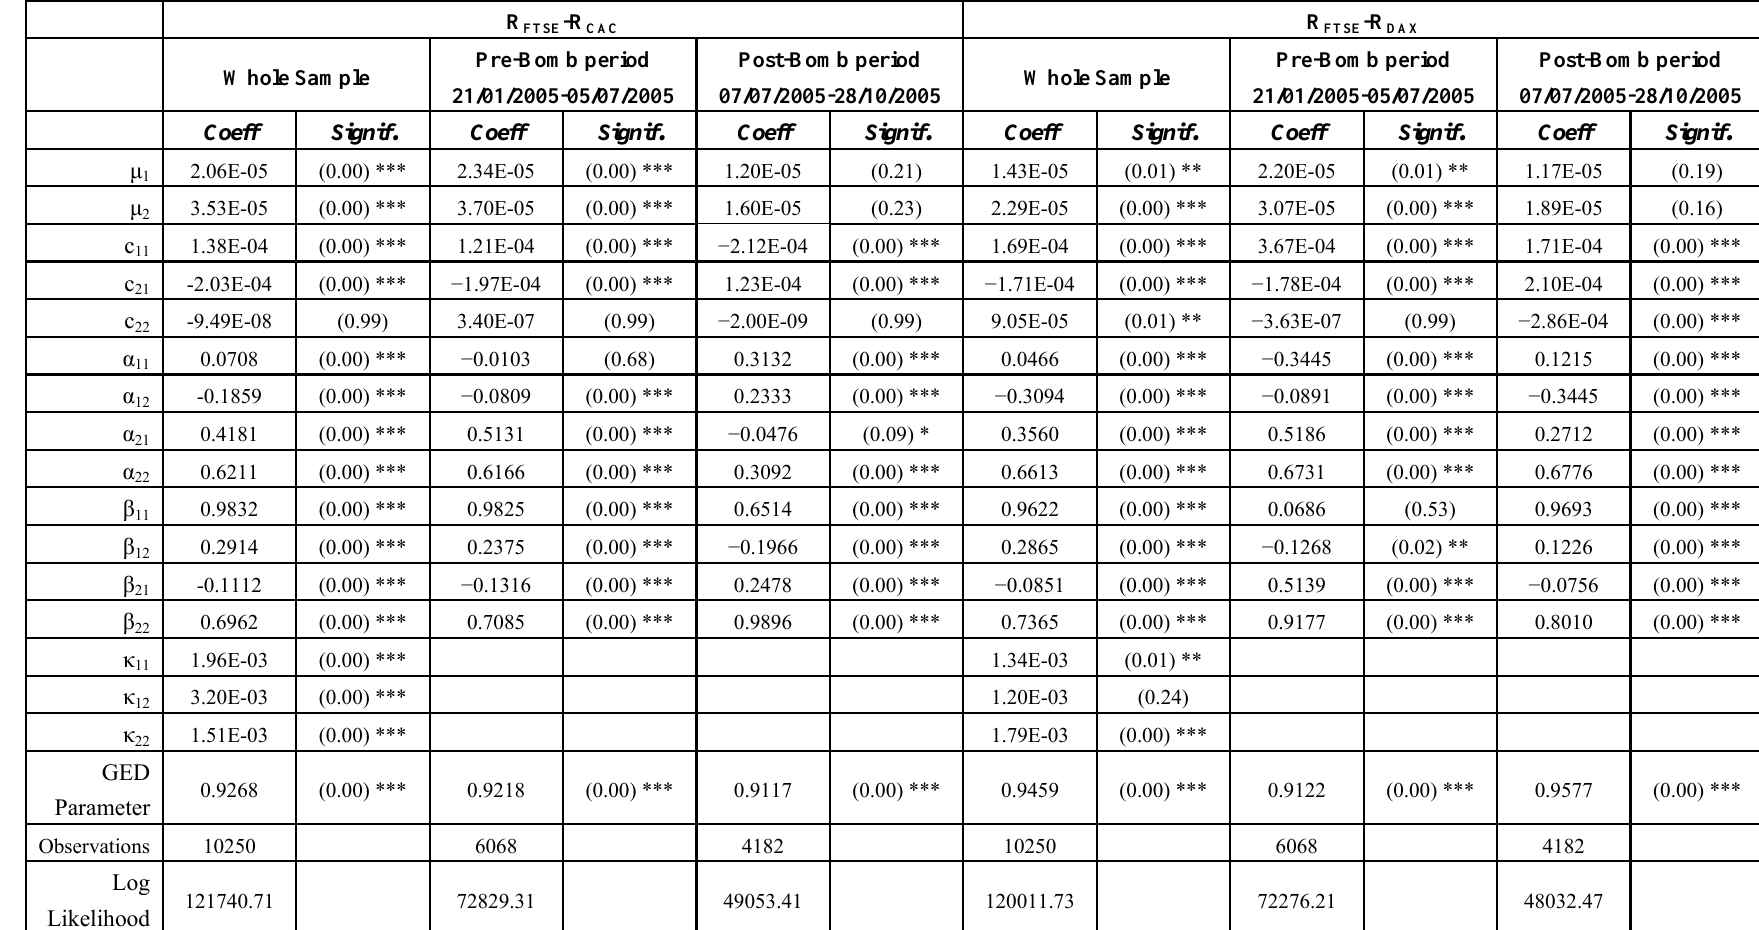
Table 3. BEKK-GARCH estimation